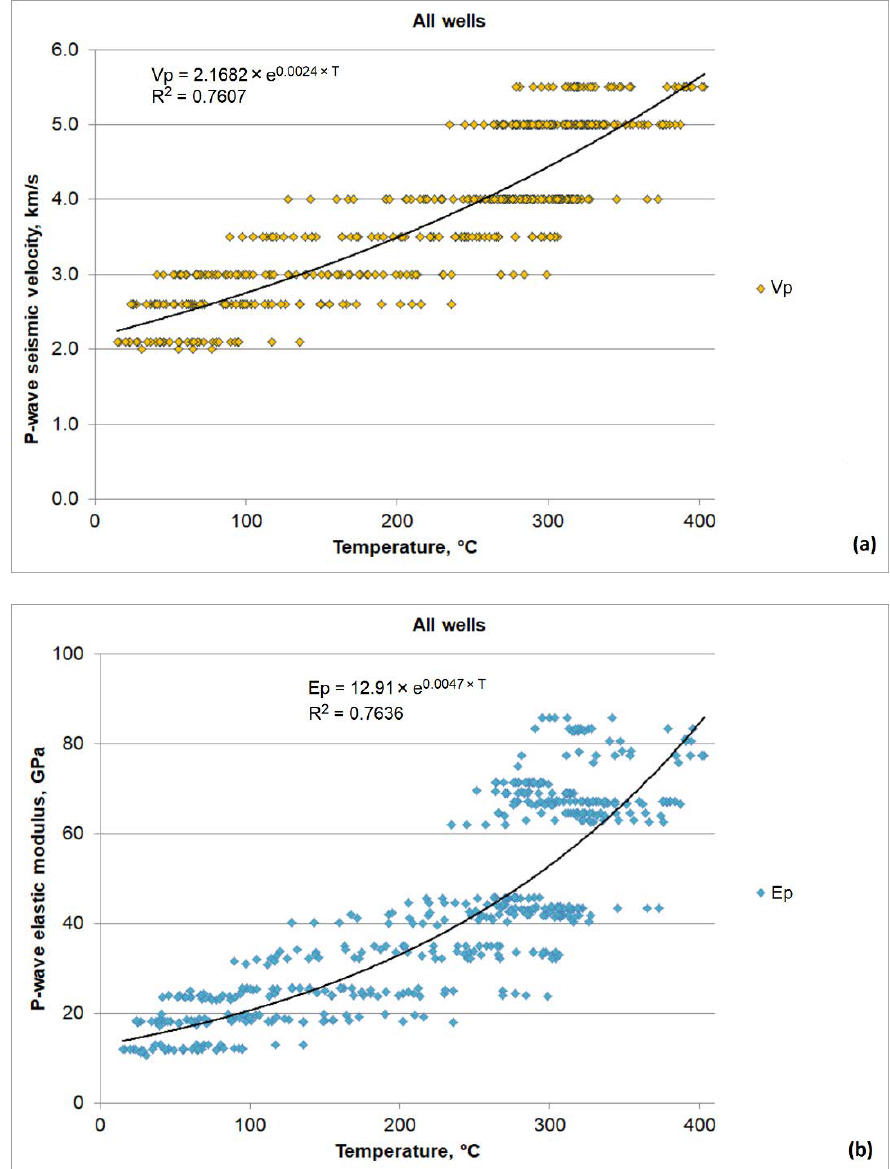
Figure 4. The 3-D p -wave seismic velocities V P ( a ) and elastic modulus E P ( b ), as derived from the active seismic survey, as a function of natural state temperatures in Los Humeros.